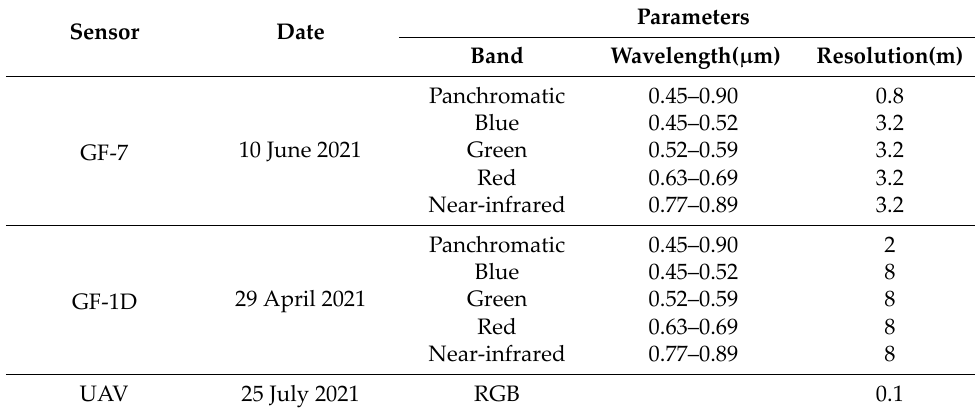
Table 1. The images used in this study and the band